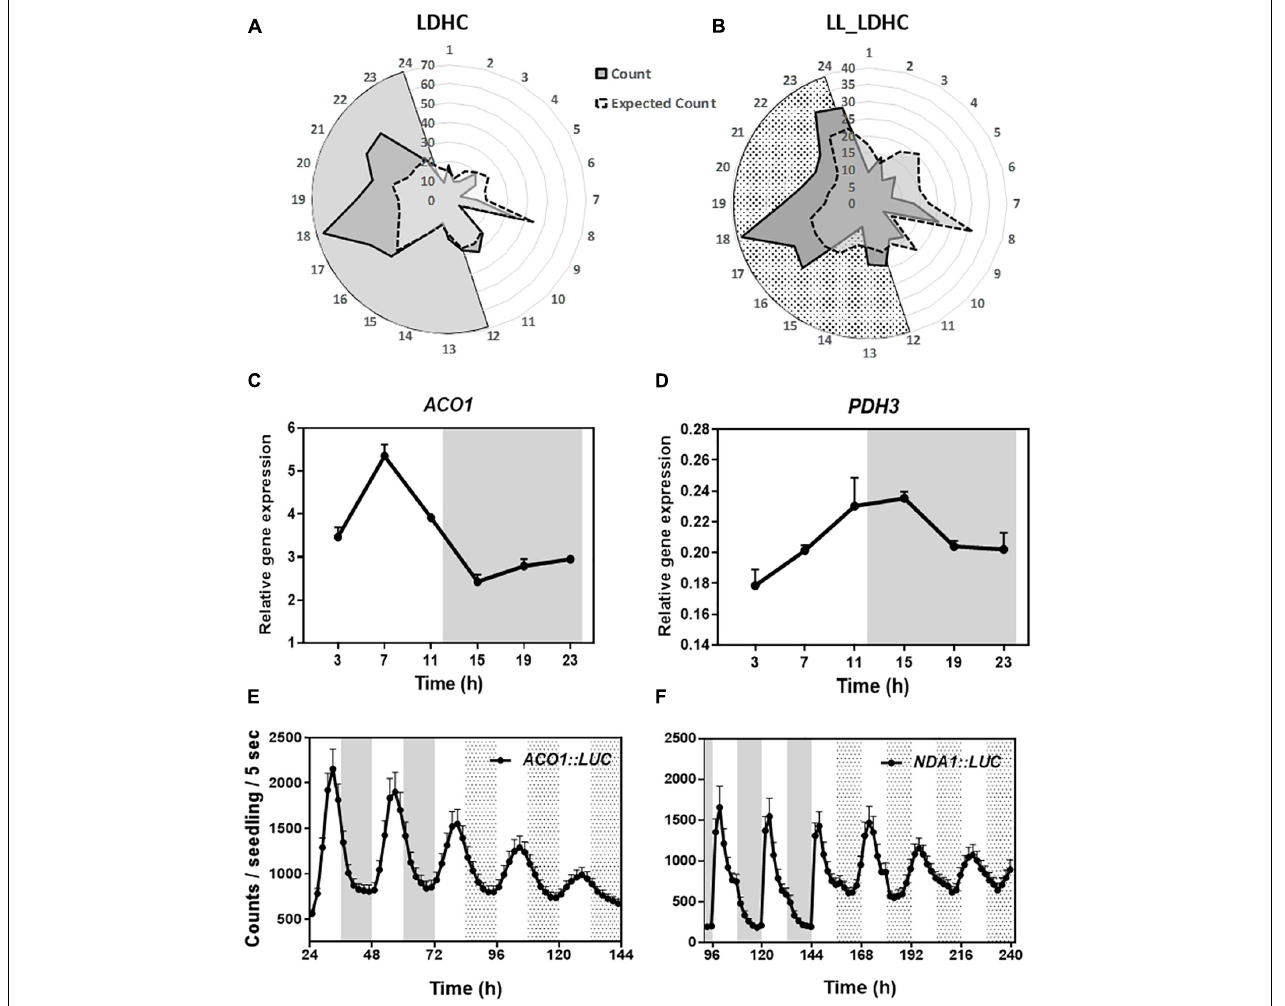
FIGURE 1 | Diel and circadian oscillation of mitochondrial-related gene expression. Peak phases of expression of mitochondrial-related genes represented in radial plots under (A) LDHC and (B) LL_LDHC conditions. Radial axis: 24-dawn, or subjective dawn; 12-dusk, or subjective dusk. Time course analyses by RT-QPCR of (C) ACONITASE 1 ( ACO1 ) and (D) MITOCHONDRIAL PYRUVATE DEHYDROGENASE SUBUNIT 2-1 ( PDH3 ) gene expression under diurnal conditions. Data are represented as the mean + SEM. Promoter activities of (E) ACO1 fused to LUCIFERASE ( ACO1:LUC ) and (F) ALTERNATIVE NAD ( P ) H DEHYDROGENASE 1 ( NDA1 ) fused to LUC ( NDA1:LUC ) under diurnal and free-running conditions. Data are represented as the mean + SEM. The white and gray areas in panels (A,C–F) represent day and night, respectively. The white and dotted areas in panels (B,E,F) represent subjective day and subjective night, respectively. Three biological replicates were performed for all experiments, with plants grown independently, and with samples collected, processed and analyzed at different